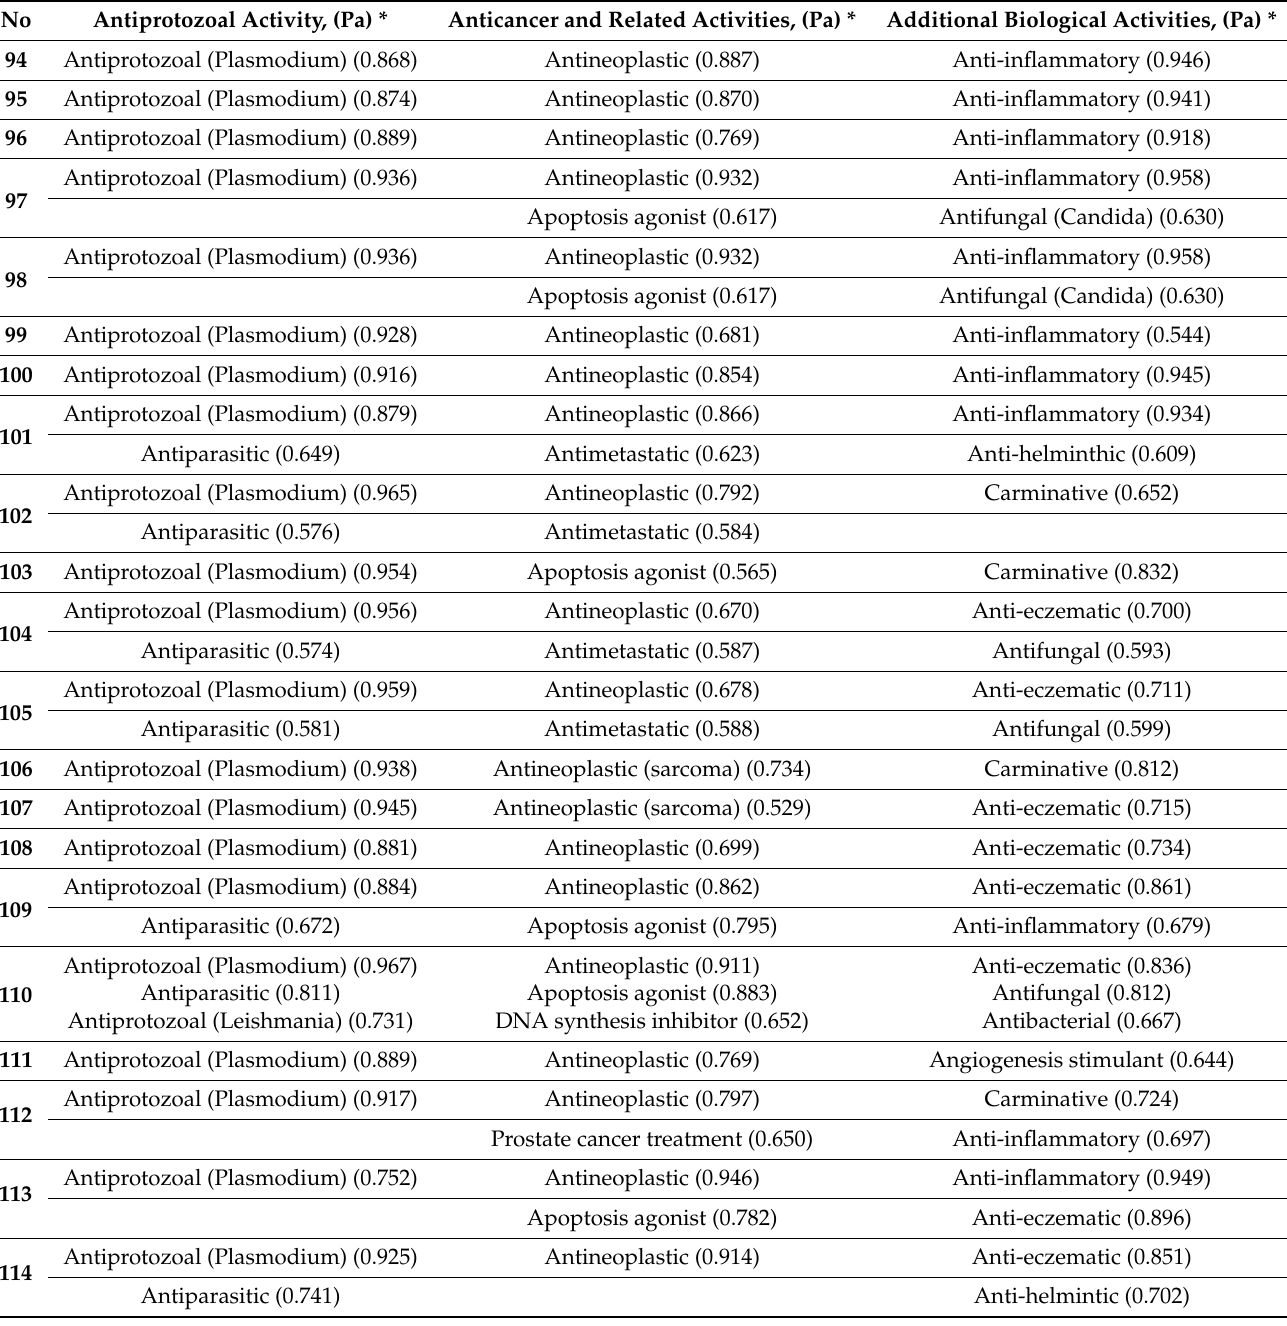
Table 7. Biological activity of natural polycyclic peroxides derived from